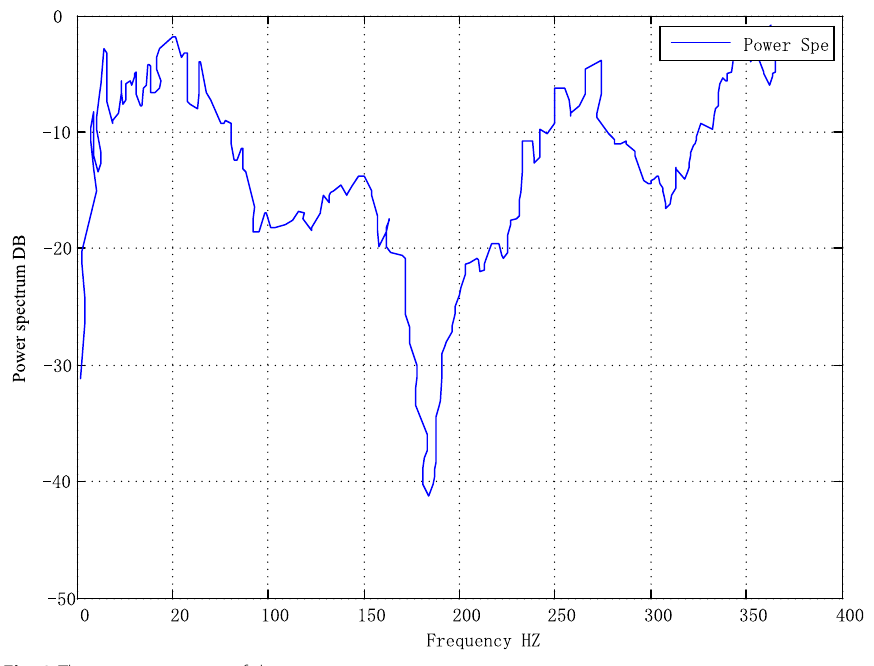
Fig. 3 The power spectrum of the